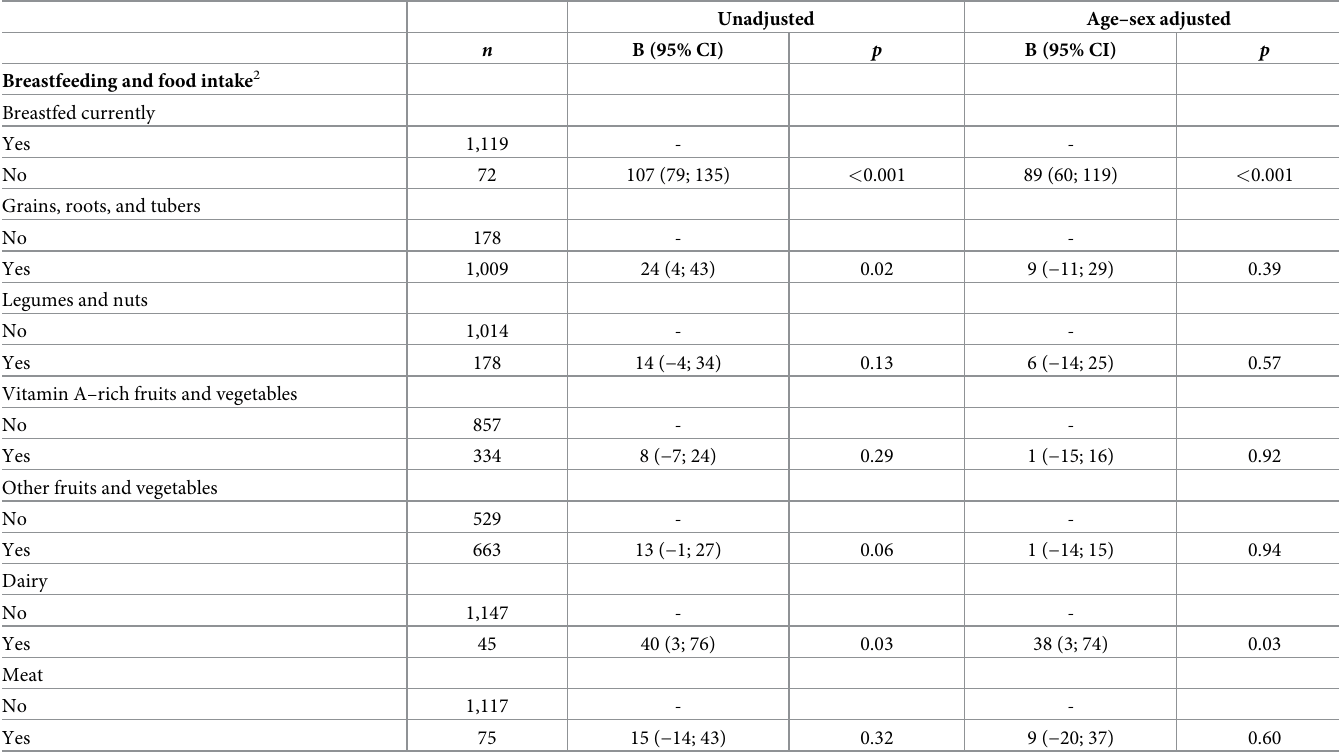
Table 3. Breastfeeding and food groups as correlates of baseline SC (pmol/L) in 1,192 children with MAM 1 .